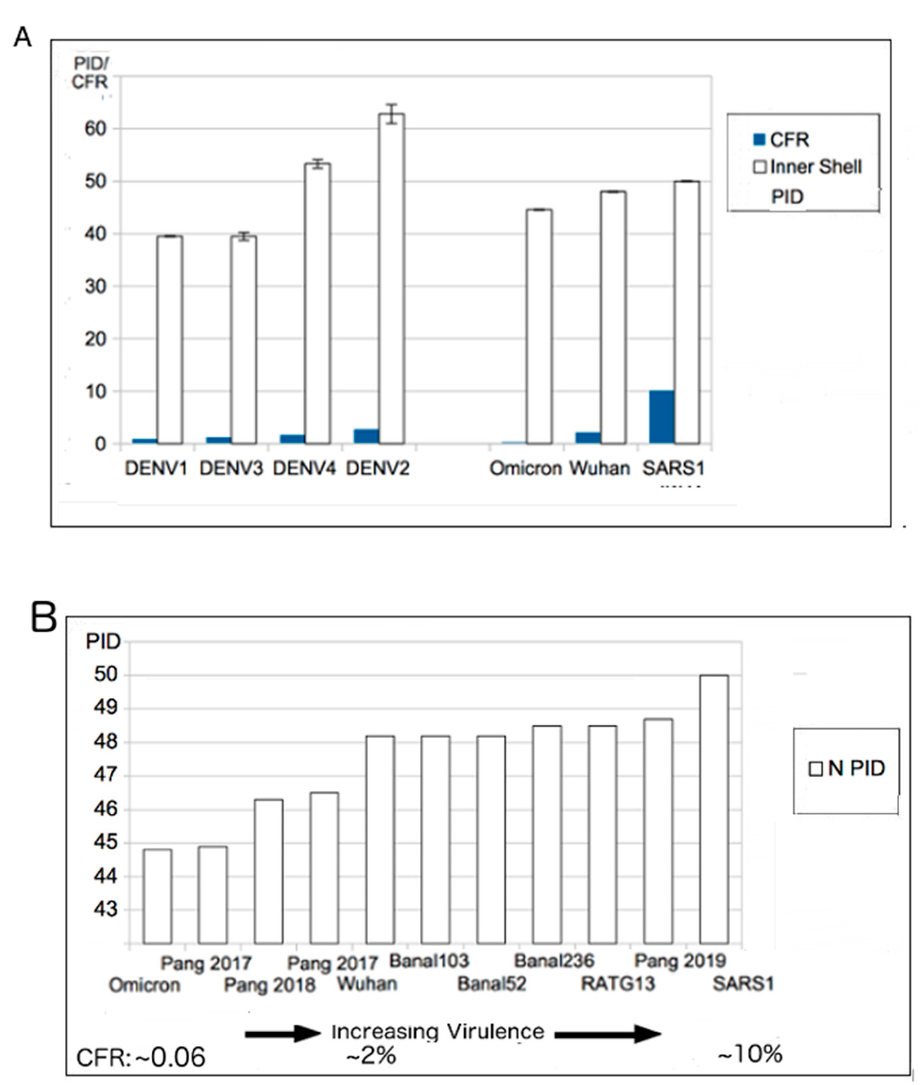
Figure 2. Virulence-Inner Shell Disorder Model as Applied to DENV and COVID-19. ( A ) Correlation of DENV virulence with inner shell (NP) disorder (r = 0.95) [26]. ( B ). Correlation between SARS- related viruses and PID N . The correlation is based on estimated case fatality ratios (CFRs) of SARS-CoV-1/2 and Omicron. The two values for Pang 2017 (pangolin-CoV 2017) are based on the two separate isolates collected in 2017. Further details on the accession codes can be found in Table 3. ( B ): Taken in part from Biomolecules. 2022;12(5). © 2022 Goh et al., Published by MDPI AG, Open